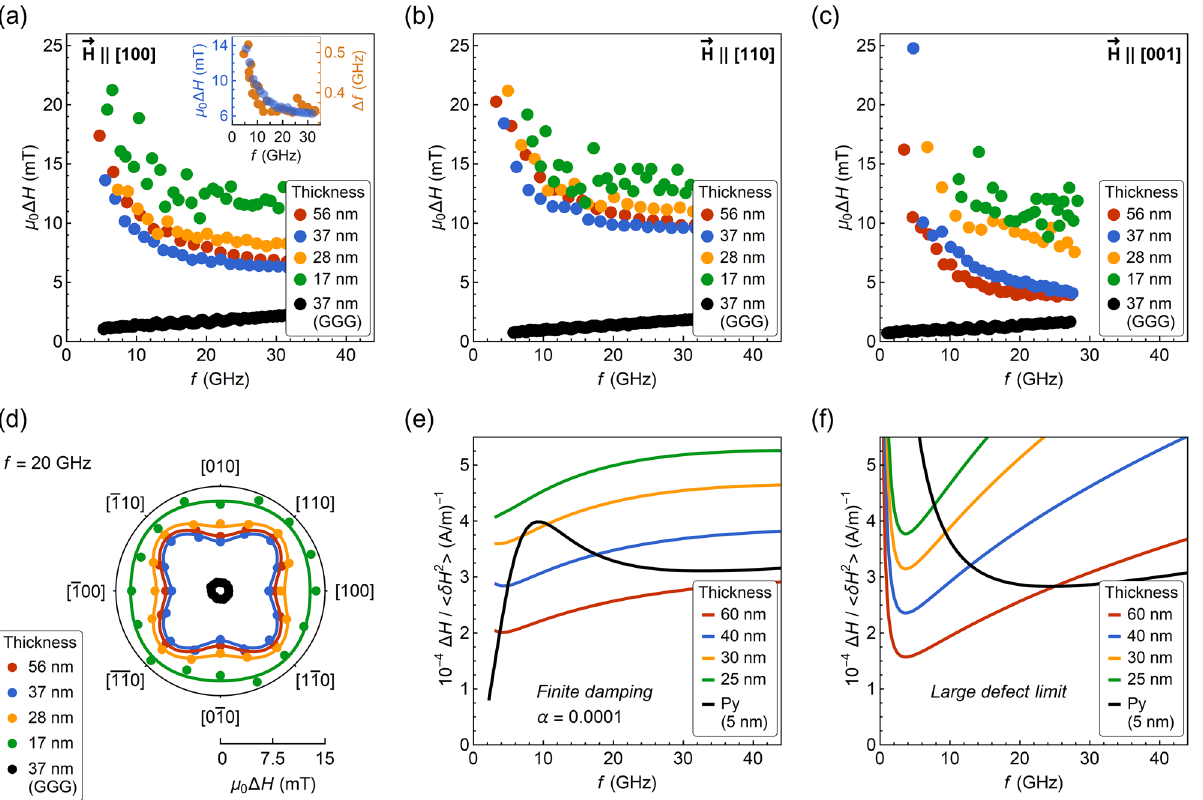
Figure 3. ( a )-( c ) Linewidth dependence on frequency for different orientations of the magnetic field with respect to crystallographic directions. The inset in ( a ) shows a comparison of linewidth changes for the field- and frequency-swept measurements of 37 nm thick film. ( d ) In-plane angular dependence of linewidth recorded at a constant frequency f 20 GHz. ( e ) and ( f ) Two-magnon contribution to the linewidth as a function = of frequency calculated for finite damping ( e ) and large defect limit ( f ). The color lines correspond to films with a saturation magnetization of M s 120 kA/m, while the black line denoted as “Py”, corresponds to a film with = M s 800 =